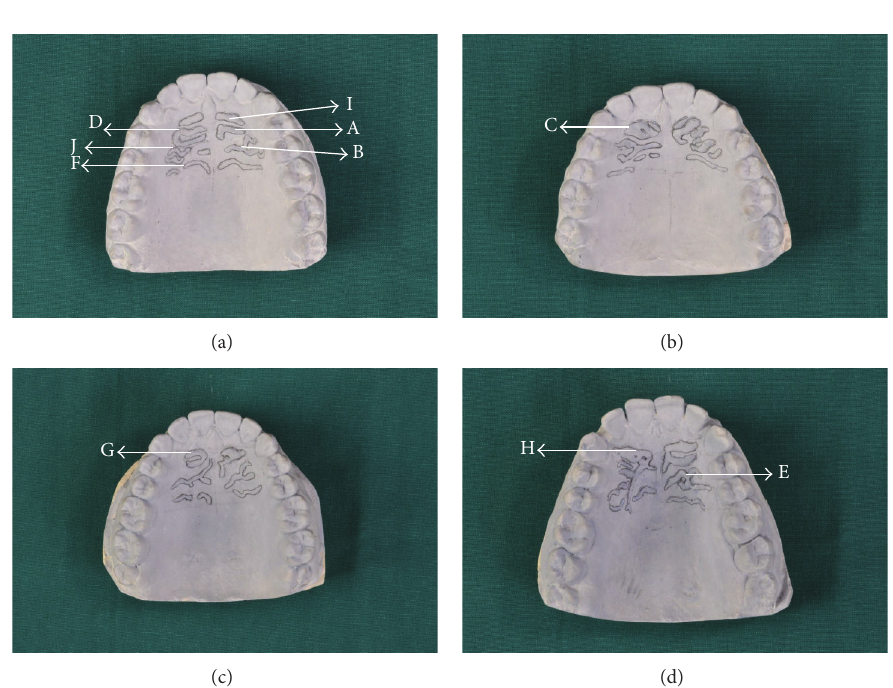
Figure 1: (a), (b), (c), and (d): different types of palatal rugae shape delineated in maxillary casts. A: angular, B: branching, C: circular, D: converging, E: crosslink, F: curved, G: diverging, H: nonspecific, I: straight, and J: wavy.